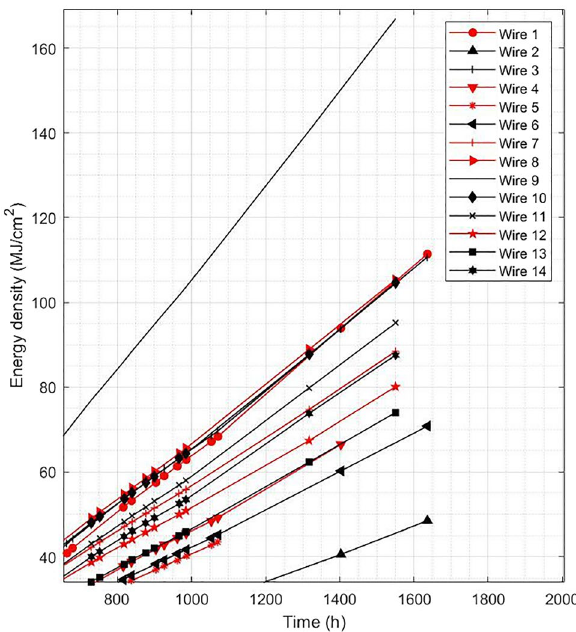
Figure 5. Cumulated energy density (MJ/cm 2 ) recorded for 14 wire electrodes tested for 1550–1630